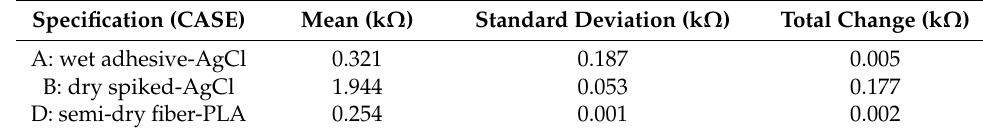
Table 2. The impedance drifts of the test samples (15-min measurements at 50 kHz).